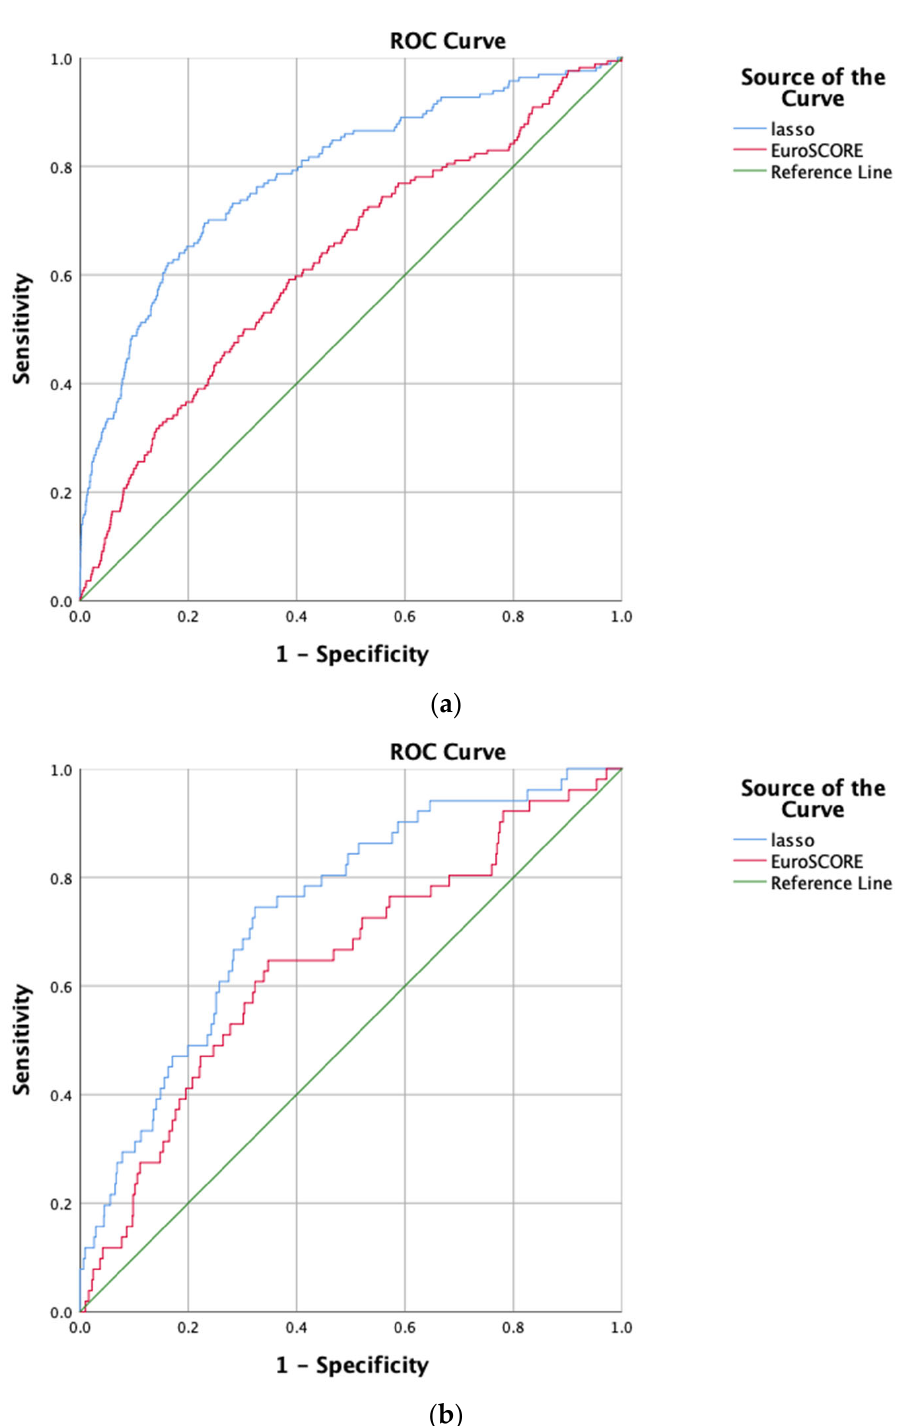
Figure 4. ( a ) ROC of LASSO ‐ logistic regression and the EuroSCORE II in training cohort. ( b ) ROC of LASSO ‐ logistic regression and the EuroSCORE II in testing cohort.